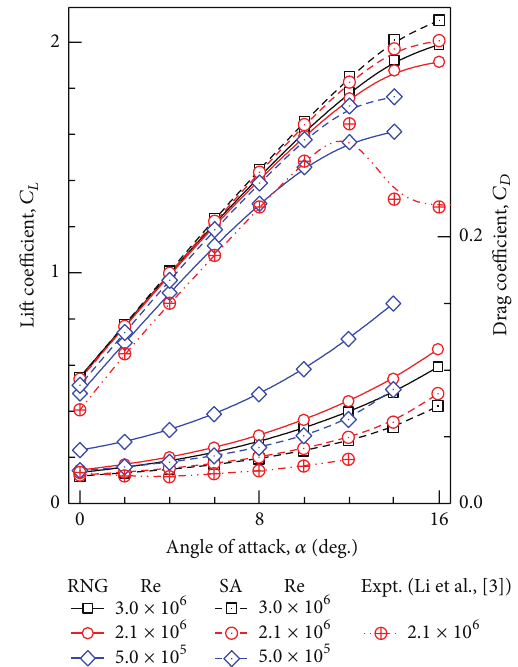
Figure 2: Variation of 𝐶 𝐿 and 𝐶 𝐷 with AoA for 𝜅 - 𝜀 RNG and SA turbulence